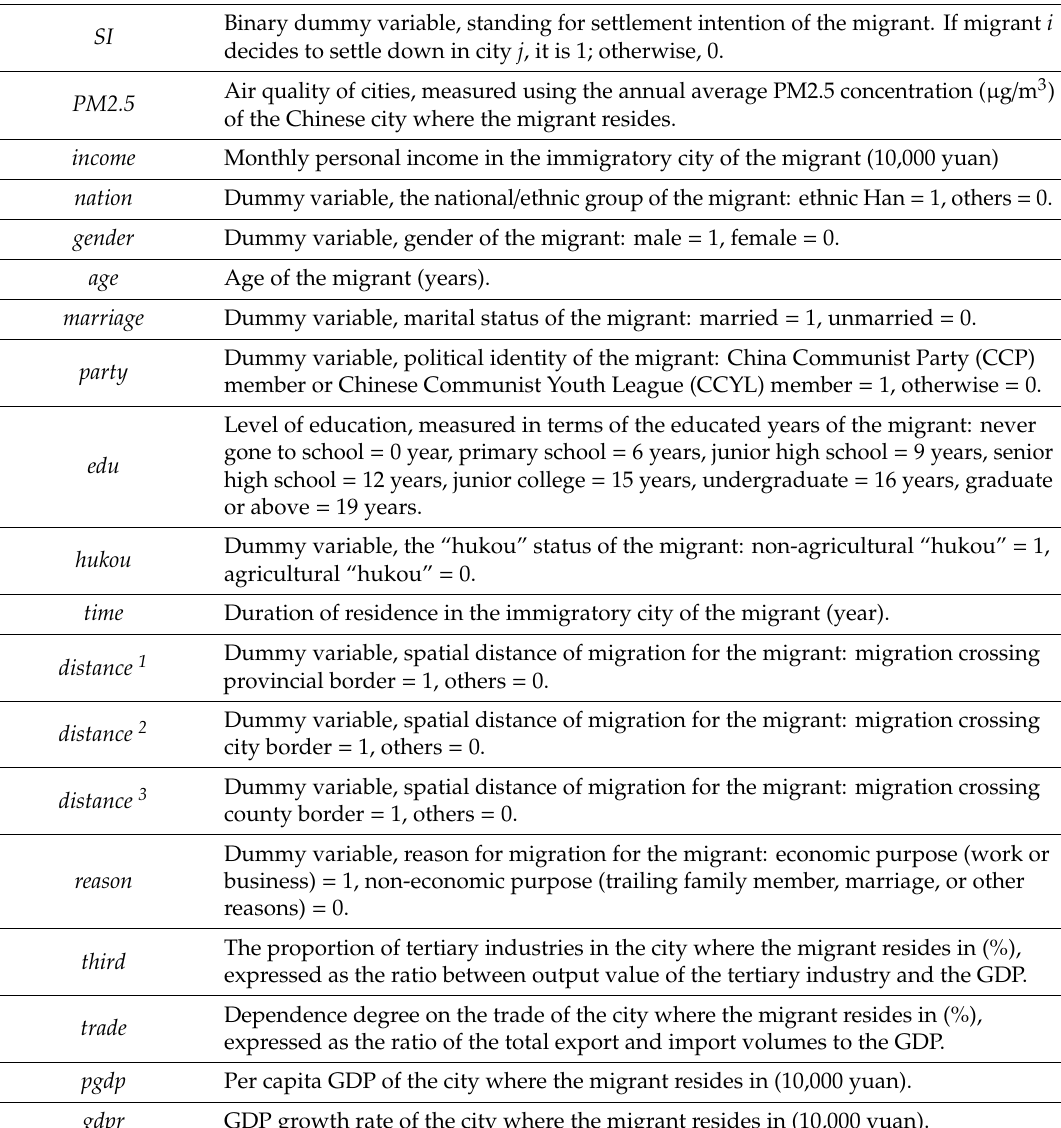
Table 2. Definitions of